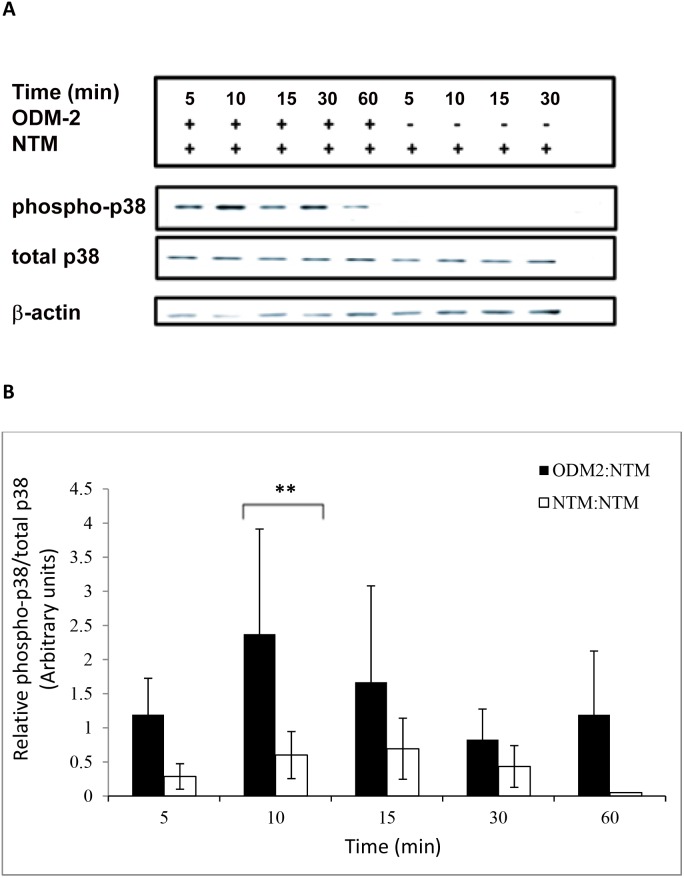
p38 activation in NTM cells co-cultured with ODM-2 cells for 5, 10, 15, 30, 60 min.Total protein was extracted from NTM cells. Phosphorylated and total p38 proteins were analyzed by Western blot. (A) Representative western blot film. (B) A significant increases in p38 activation in NTM cells following co-culture with ODM-2 cells. The bar graph represents the means ± SD of three independent experiments performed in duplicates. One-way ANOVA (**p<0.01).